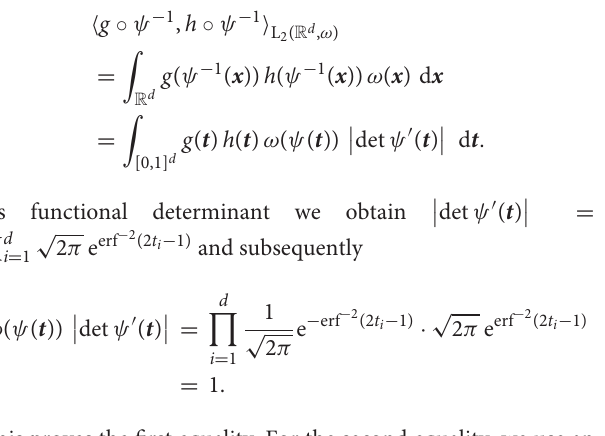
1 (solid), k 2 (dotted), = =